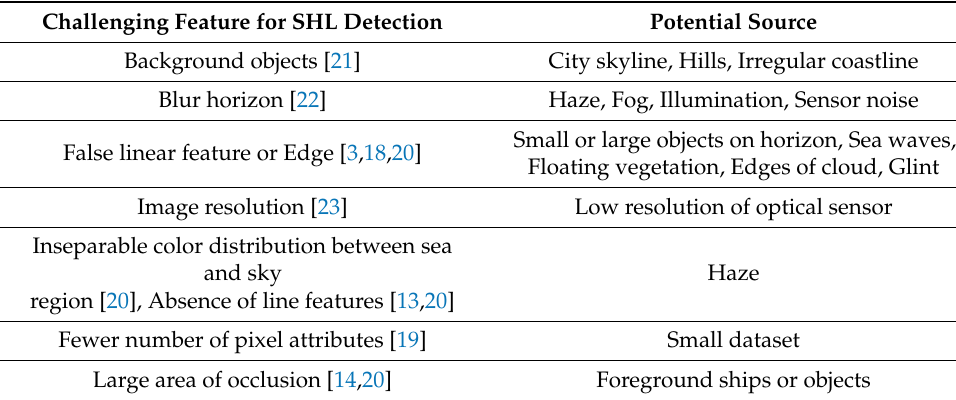
Table 2. A challenging feature matrix for SHL detection. Challenging Feature for SHL